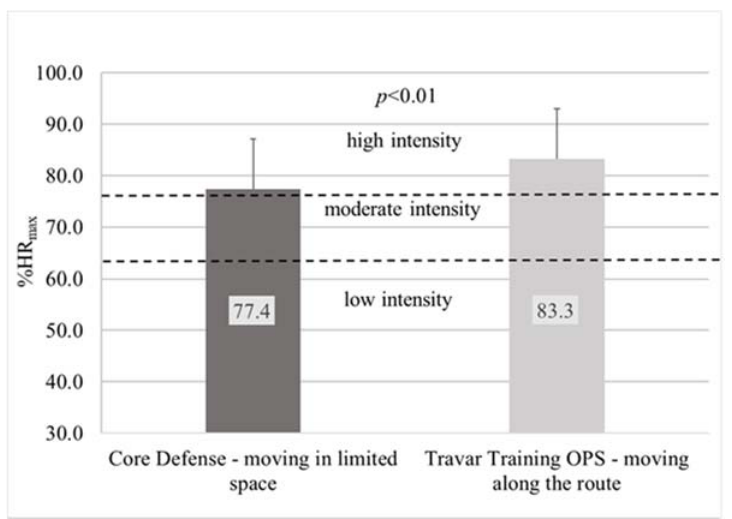
Figure 5. Average intensity of PA of obese children during PA in IVR on an omnidirectional treadmill depending on the type of video game.